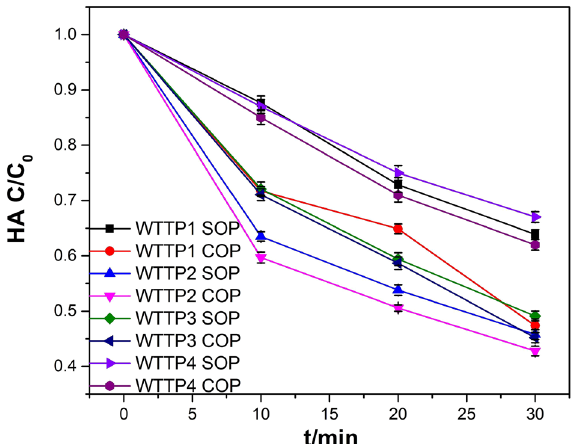
Figure 7. HA removal in four samples of biochemical effluent wastewater (experimental conditions: unadjusted pH